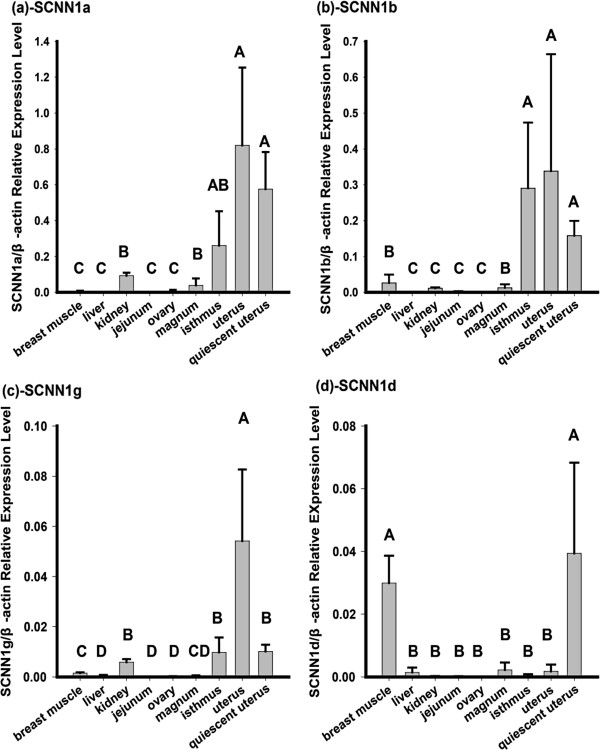
Comparison of relative expression of SCNN1 gene family members vs β-actin measured by qPCR in different tissues. The kidney was collected from four normal 49-Week-old White Leghorn layers while all others tissues, breast muscle, liver, jejunum, ovary, magnum, isthmus, active uterus (during eggshell deposition) and quiescent uterus (no egg present at time of tissue collection) were collected from four normal 55-week-old White Leghorn layers. The y-axis indicates the relative expression level of each SCNN1 family member. Different letters (A,B,C, D) represent significant difference (P < 0.05). Panel (a), Panel (b), Panel (c) and Panel (d) represents the expression of the SCNN1a, SCNN1b, SCNN1g and SCNN1d, respectively.